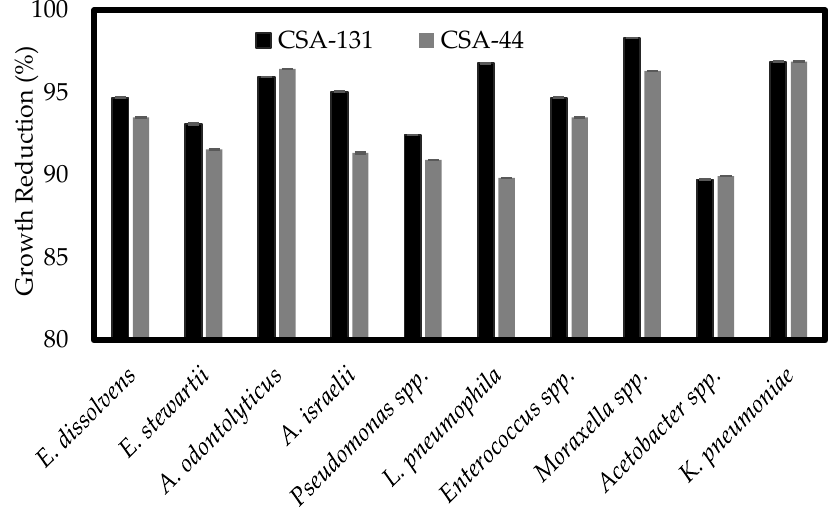
Figure 3. Reduction of established biofilms of ten isolates after 48 h incubation with CSA-131 or/and CSA-44 (100 µ g/mL). Using the 2,3-bis (2-methoxy-4-nitro-5-sulfophenyl)-5-[(phenylamino) carbonyl]-2H-tetrazolium hydroxide (XTT) colorimetric based assay, metabolic activity of